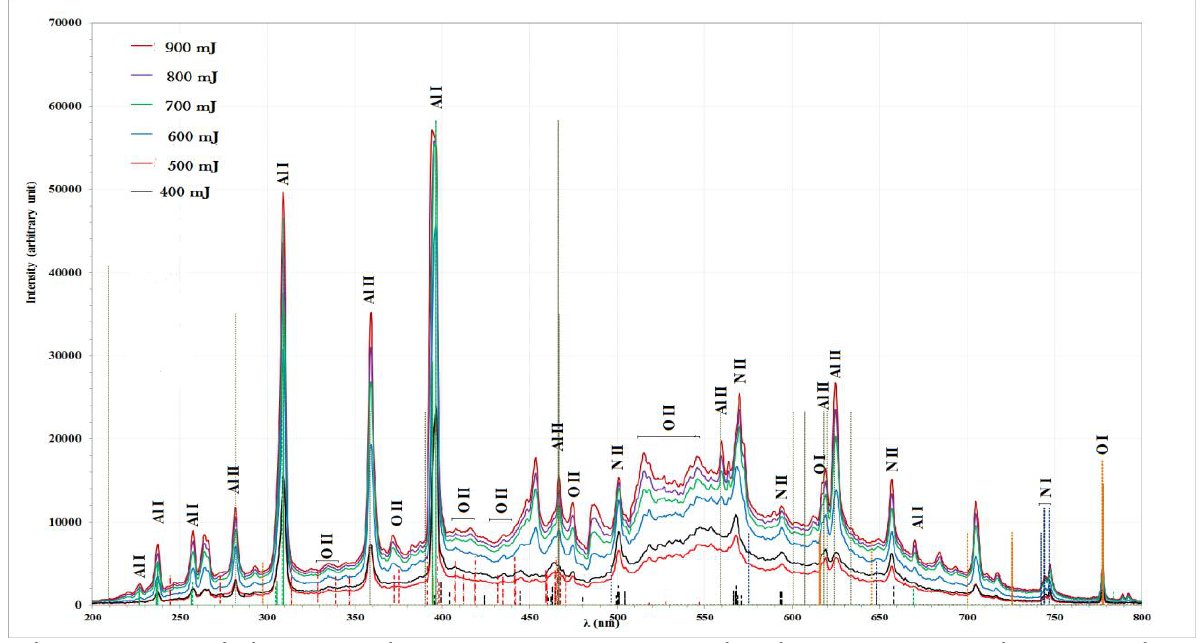
Fig.2: Plasma emission spectra induced by 1064 nm laser, with different laser energies for aluminum powder in air.